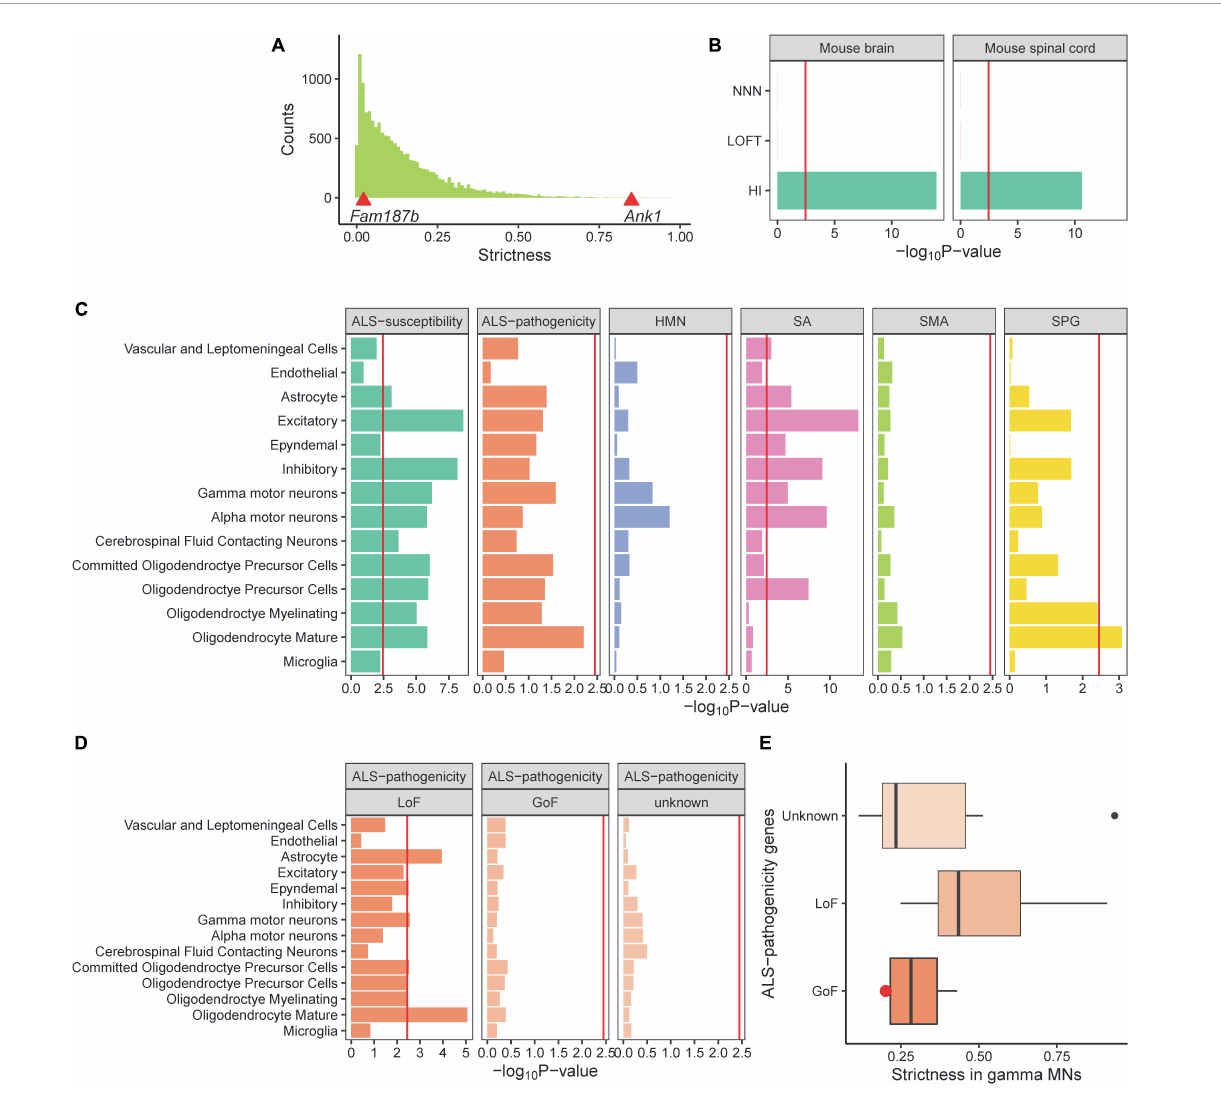
FIGURE3 The strict dosage requirement of ALS-related genes in MNs. (A) The histogram displays the distribution of strictness value of all genes in brain cells. Strictness values for Fam197b and Ank1 are exhibited by the red triangles. (B) Comparison of three gene panels with known strictness in mouse brain and spinal cord. (C) ALS-susceptibility genes dosage is required strictly in MNs. (D,E) LoF ALS-pathogenicity genes are required strictly in γ -MNs and no evidence are observed for GoF genes or unknown category. Red point refers to the Sod1